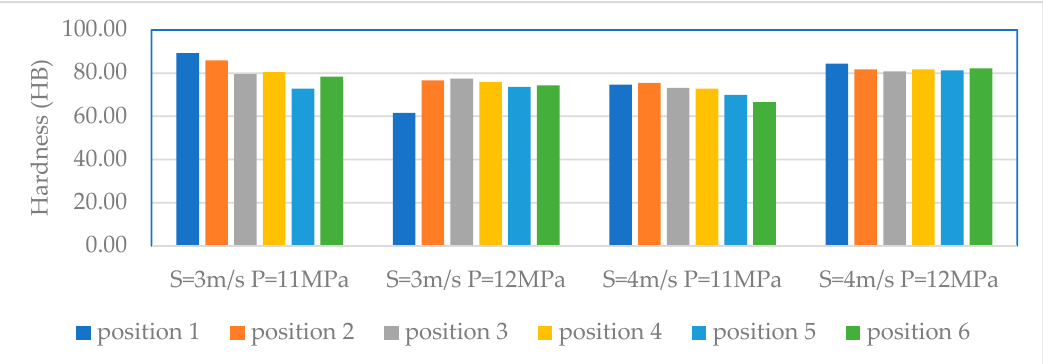
Figure 15. Cross - sectional microstructures in position no . 4 at various injection conditions of rheo - die-cast A356 / SiC ( 15%SiC - 15µm ) of ( a ) Speed = 3 m / s, Pressure = 11 MPa; ( b ) Speed = 3 m / s, Pressure = 12 MPa; ( c ) Speed = 4 m / s, Pressure = 11 MPa; and ( d ) Speed = 4 m / s, Pressure = 12 MPa .